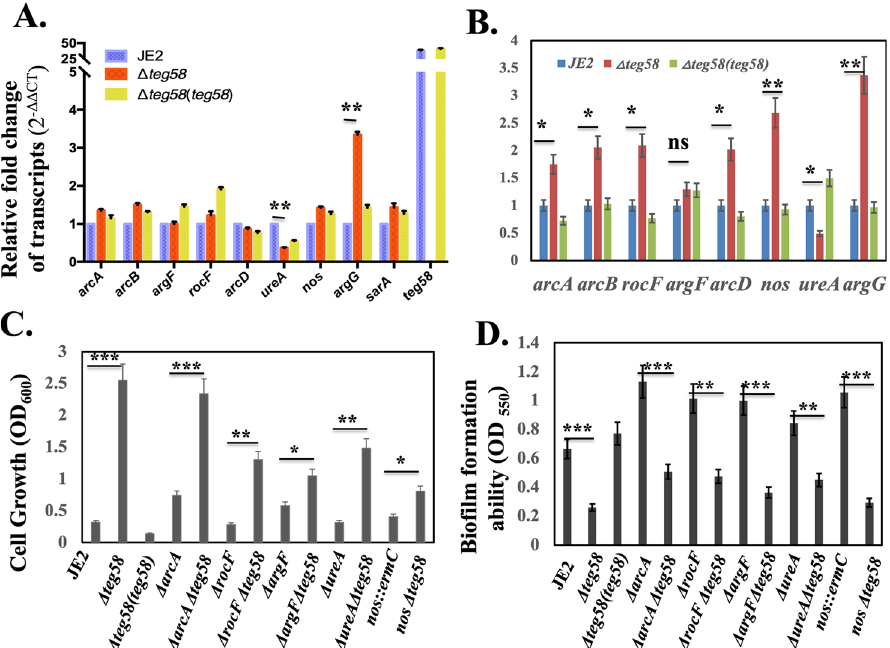
Figure 8. Analysis for the l-arginine catabolic pathway genes in teg58 -mediated biofilm formation. ( A , B ) Real-time qRT-PCR analysis, along with the rpoB control, were evaluated by qRT-PCR (2 −ΔΔCT ) using total RNA isolated from the respective strains at 24 h grown biofilm cells ( A ) and post-exponential phase of aerobically grown cells ( B ) in TSB. The data were normalized against rpoB as the reference transcript for qRT-PCR. Relative expression of the genes was plotted against the wild type set as 1.0. ( C ) Growth analysis in CDM lacking l-arginine for various arginine catabolic pathway mutant strains as indicated. Growth was performed for 48 h at 37 °C in an incubator shaker. ( D ) Biofilm formation for various strains in TSB with 0.25% glucose for 24 h in a microtiter plate. Means and standard deviations from triplicate experiments are shown. Student t -test (* P < 0.05,